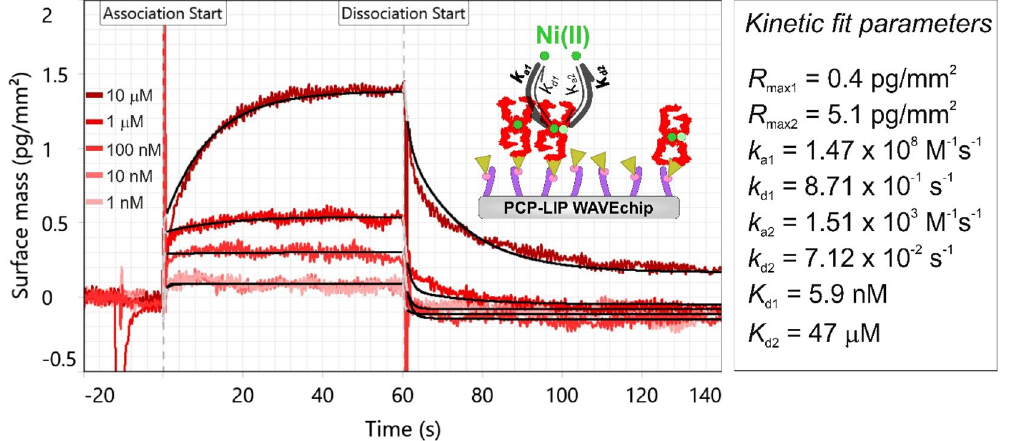
Figure 7. Measured kinetic data of Ni(II) binding obtained at low FliC-NikR C coverage on a PCP-LIP WAVEchip (red curves). The shown measurement curves were adjusted and represent Ch1 - Ch2 reference corrected data. The data were fitted using the heterogeneous ligand kinetic model (black curves). The inset scheme illustrates the binding of Ni to the FliC-NikR C tetramers which were immobilized on the quasi-planar lipophilic surface of the PCP-LIP chip. While the solid circles with dark green color represent Ni(II) ions bound to the HA sites, the light green circles represent Ni(II) ions bound to the LA